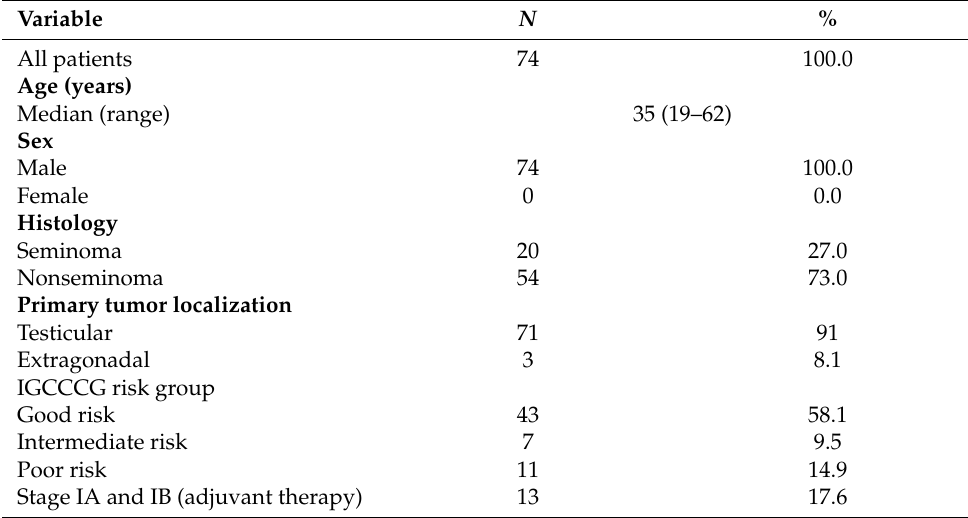
Table 1. Clinicopathological characteristics of GCT